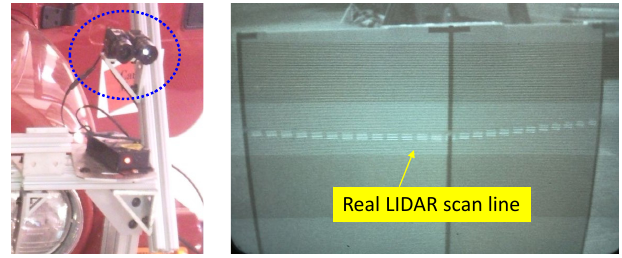
Figure 4. Two test platforms used for the experiments: we used two different sensor configurations for the experiments. ( a ) A single scanning LiDAR and a camera used for the performance evaluation of the proposed weighted and robust calibration approaches; ( b ) 3D LiDAR and cameras used for the joint calibration.